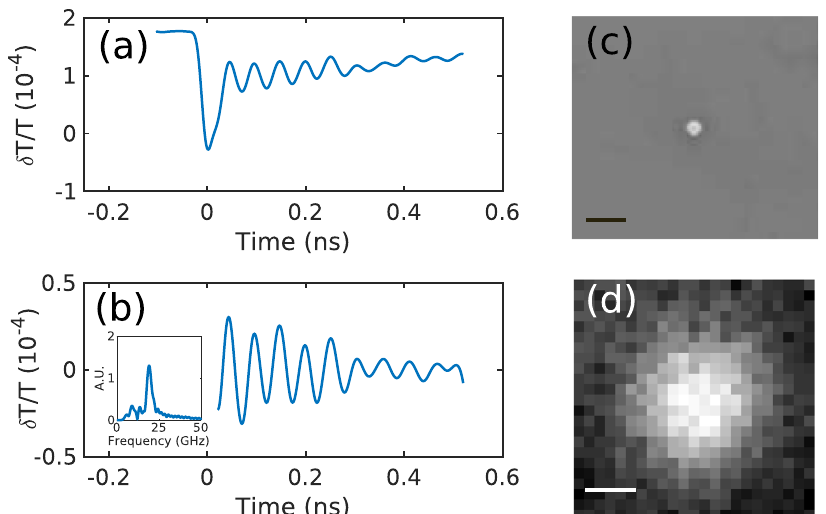
Figure 3. ( a ) Raw signal centred on the particle, ( b ) signal after processing to extract the change in scattering cross section as the particle vibrates (inset frequency content), ( c ) SEM of the particle and ( d ) optical image of same particle. Scale bars in ( c ) and ( d ) 500